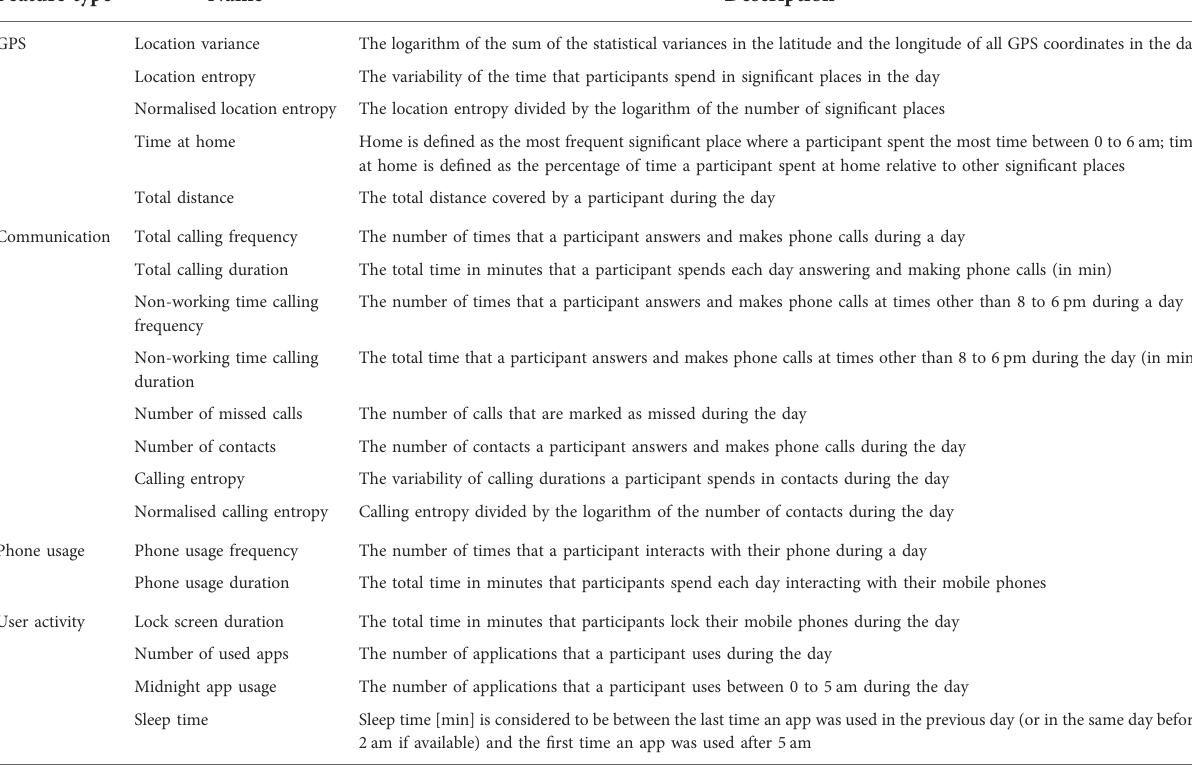
TABLE 1 Features extracted from the passively collected MAIKI